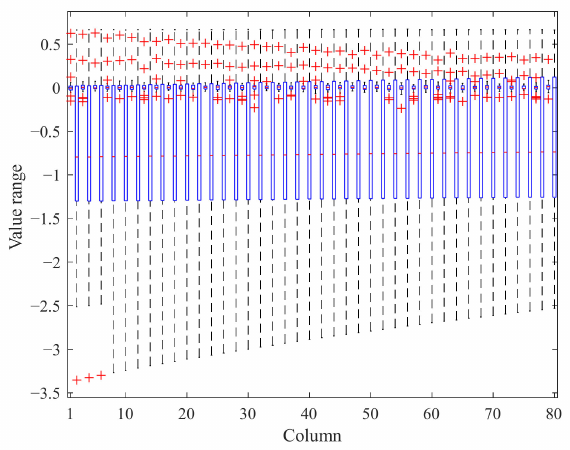
Figure 11. Box plot of a single